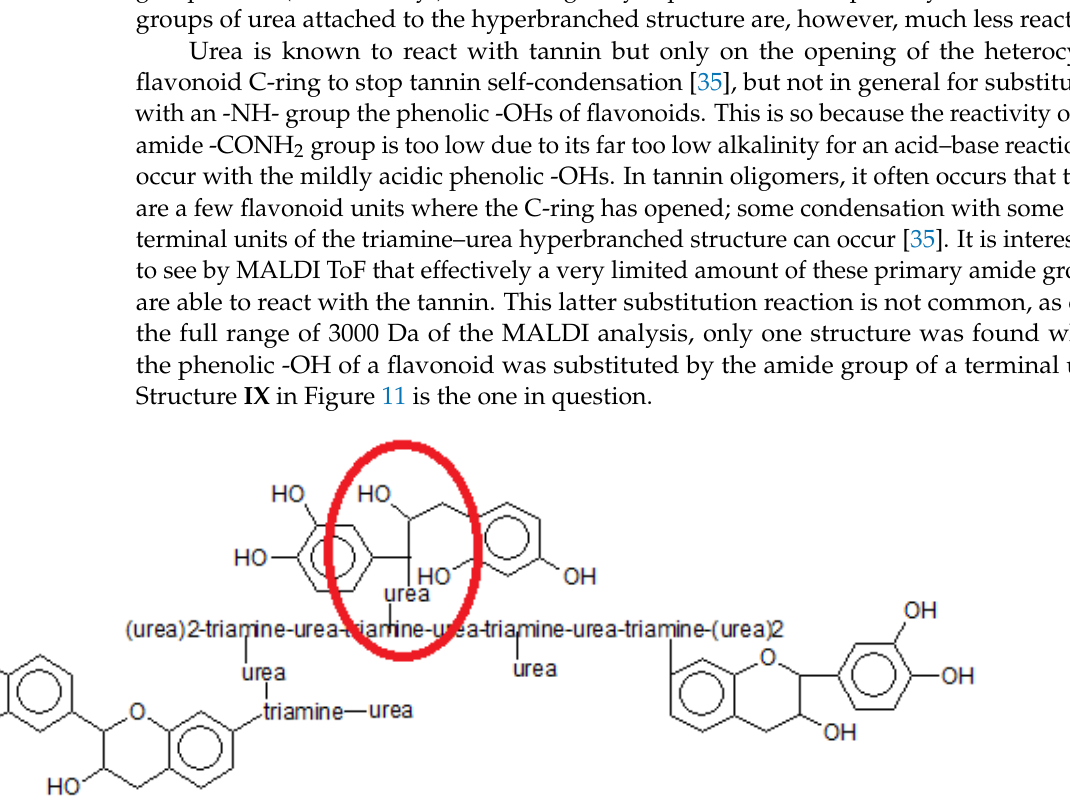
( X ) Figure 12. An example of a flavonoid unit linking two hyperbranched triamine-urea structures. These species indicate that, when necessary, even the phenolic hydroxyl groups of the B-ring of the tannin can link to the hyperbranched triamine–urea oligomers. From the above, it is also evident that the tannin oligomers do function as nucleation sites and hardeners of the tris(2-aminoethyl)amine-urea hyperbranched structure, yield- ing a better hardened adhesive network. It is also very worthwhile to consider from an environmental point of view that no formaldehyde and no aldehydes are used in such a wood adhesive system. 3.6. CP MAS 13 C NMR The shifts of the alpha carbons to the aliphatic diamine –NH groups should appear at a shift of 43–44 ppm if the diamine is reacted covalently with the tannin. The same alpha